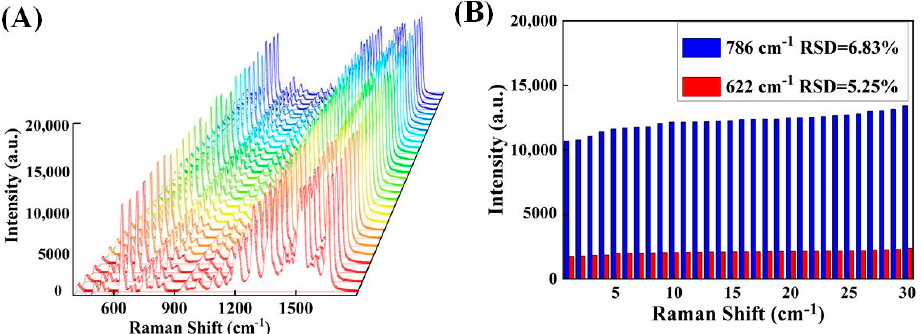
Figure 6. ( A ) Raman spectra of 30 randomly selected points on ITO/Au. ( B ) SERS peak intensity of 30 points was randomly selected on ITO/Au (786 and 622 cm − 1 ).